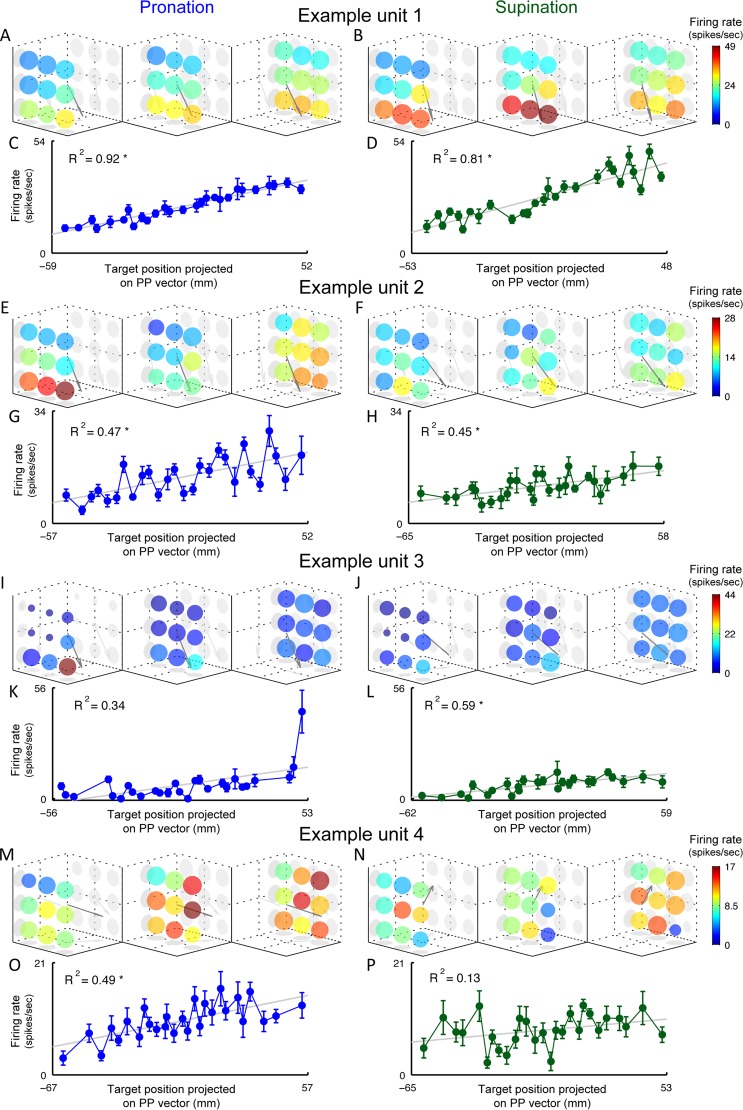
Examples of neuronal response functions.Colored plots show mean firing rates as function of 3D target position. Sphere radius is proportional to the confidence in the mean (SEM normalized by the mean), a smaller radius means lower confidence. The PP vector from the linear tuning-curve is plotted as an arrow. Left panel for pronation, right for supination. Below, mean firing rates ± SEM plotted as function of target positions projected onto PP vector. Gray line shows firing rates expected by linear tuning-curve, and its R2 (star denotes a significant F-test, p < 0.01). A-D. Neuron with one of the best fits to the linear tuning-curve in our dataset. Target positions perpendicular to the PP vector have almost equal firing rates. E-H. Neuron exhibiting spatial bimodality. I-L. Neuron with a spatially local response. M-P. Neuron with most common form of nonlinearity with high spatial frequencies (neighboring targets have large differences in firing rates).